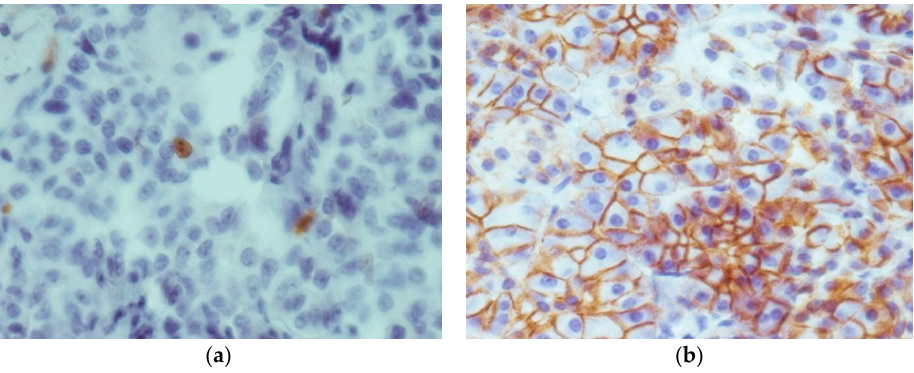
Figure 2. ( a ) 40× magnification, depicting the staining results of Ki-67 (note the proliferating cell in